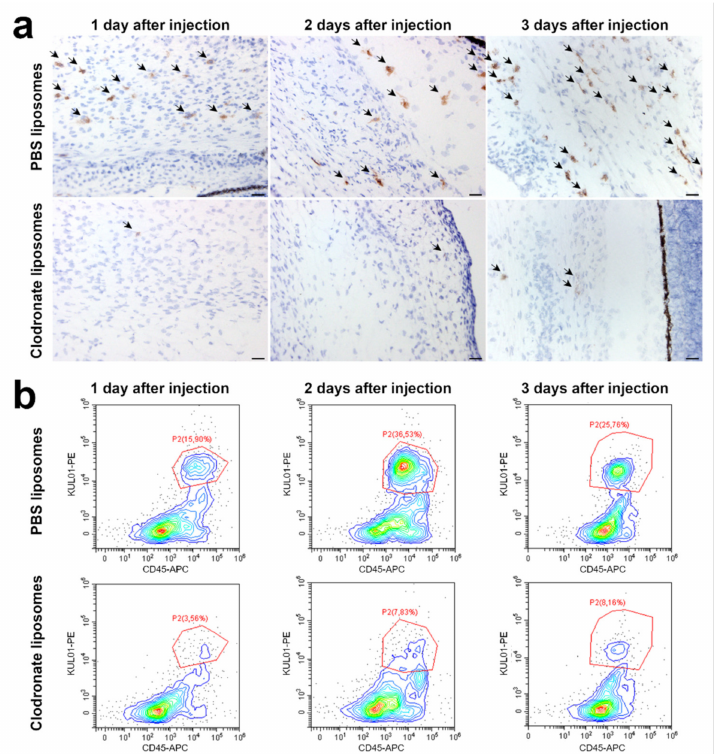
Figure 2. Injection of embryos with clodronate liposomes leads to a depletion of macrophages. ( a ) Immunohistochemistry shows fewer KUL01-positive cells (arrows) in clodronate-injected embryos in the developing choroid and the mesenchymal tissue surrounding the eye sclera compared with chicken embryos injected with PBS liposomes. Macrophage depletion was already visible 24 h after injection of clodronate liposomes and was still visible 3 days after injection. Scalebar = 20 µ m. ( b ) Flow cytometry confirmed that injection with clodronate liposomes depletes the macrophage population. KUL01-positive macrophages decrease from 15–37% of CD45-positive leucocytes in control embryos injected with PBS liposomes to 3–9% in clodronate liposome-injected